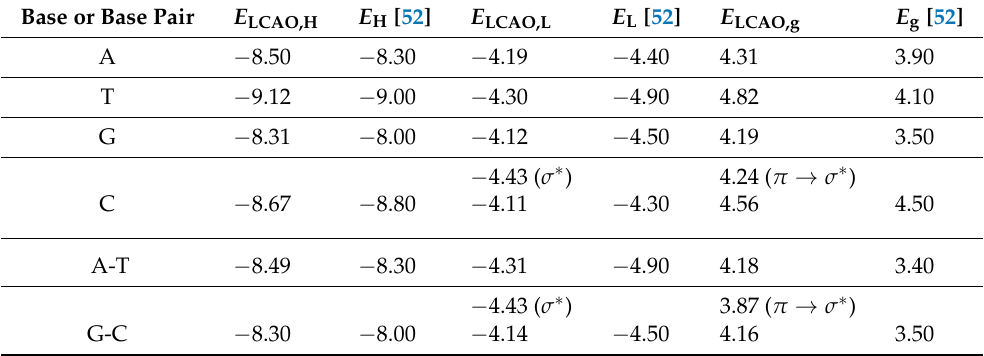
Table 5. HOMO ( E LCAO,H ) and LUMO ( E LCAO,L ) eigenenergies of the base pairs A-T and G-C, obtained in this work using LCAO with all valence orbitals, along with the corresponding HOMO–LUMO energy gaps ( E LCAO,g ) in eV (rows 6 and 7). Rows 2–5 contain the calculated HOMO and LUMO energies of each distorted base making up these base pairs. The third, fifth, and the seventh columns list the corresponding energies from Reference [52] where only 2p z orbitals had been